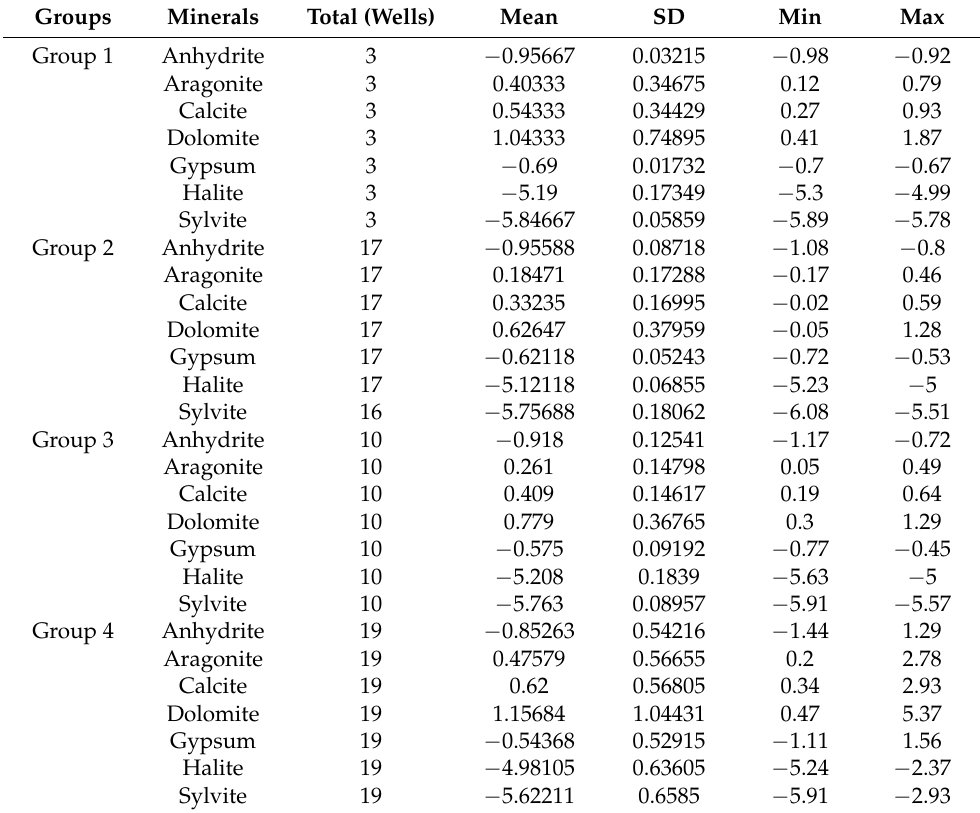
Figure 14. ( A , B ) Saturation indices of evaporate minerals. Table 6. Saturation indices of minerals in groundwater with statistical summary using